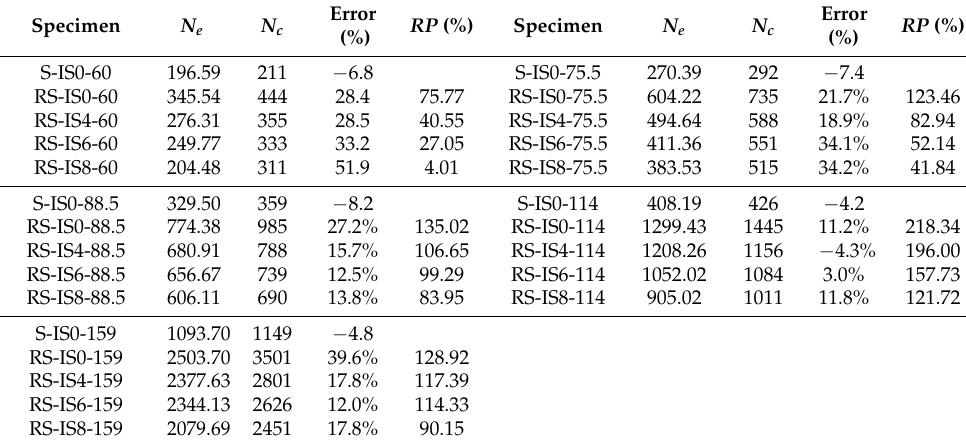
Table 4. Test results of ultimate bearing capacity